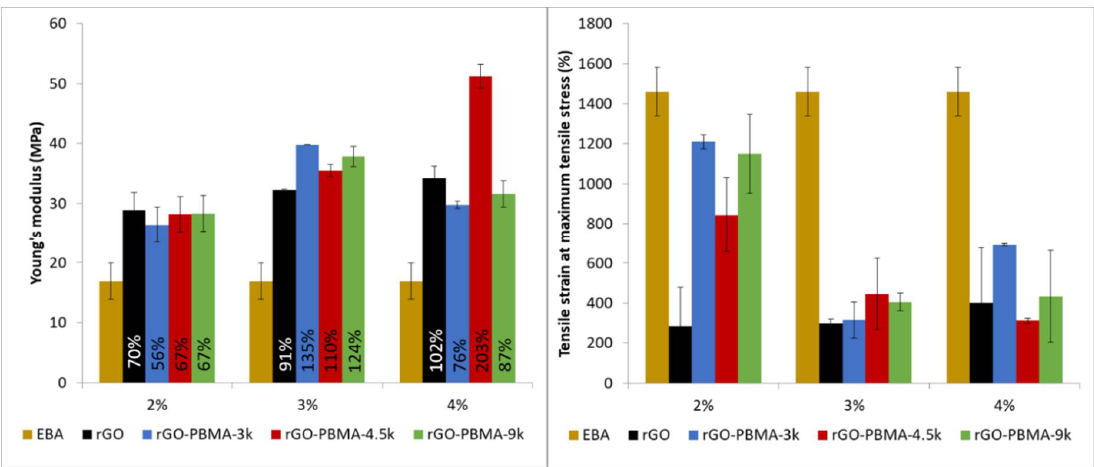
Figure 4. Young’s Modulus (left) and tensile strain at maximum tensile stress (right) of the